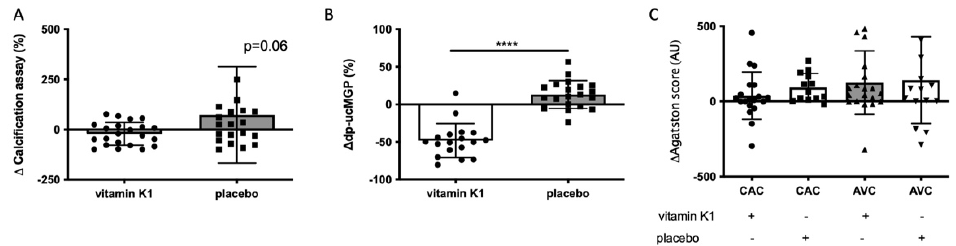
Figure 4. hVSMC calcification induction from serum of AVC and CAC patients. ( A ) In vitro calcification after 1 year vitamin K1 supplementation ( n = 22) or placebo ( n = 20). Supplementation of vitamin K1 showed a decreased response to in vitro calcification development comparing baseline serum to 12 months. Conversely, the placebo group exhibited increased in vitro calcification development in our assay ( p = 0.06). ( B ) Dp-ucMGP change after 1 year. Dp-ucMGP levels significantly decreased following 1 year of vitamin K1 supplementation ( n = 18) compared to the placebo ( n = 20) group ( p < 0.0001). ( C ) Development of Agatston score. No differences were found in either CAC or AVC score in both the vitamin K1 (CAC n = 18; AVK n = 19) and placebo (CAC n = 13; AVK n = 16) group. **** p <